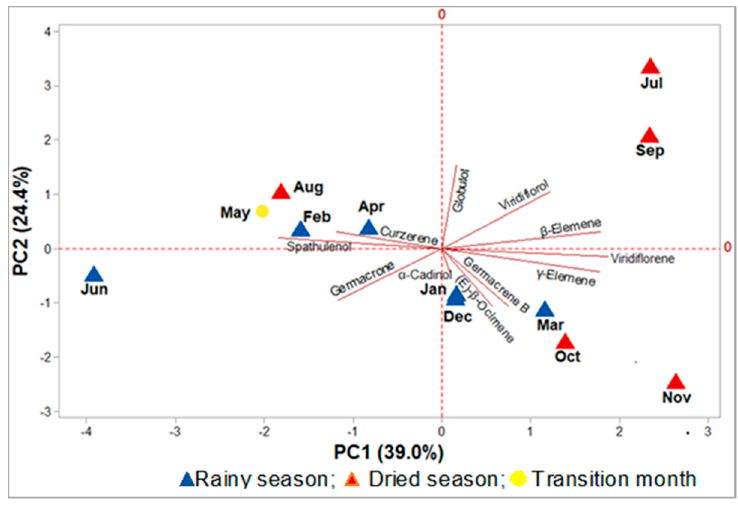
Figure 6. Principal components analysis (PCA) of the Eugenia uniflora oils, based on their primary constituents.